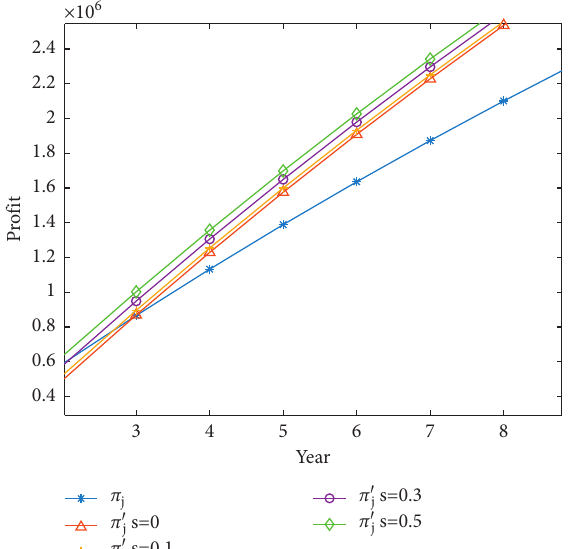
Figure 7: Profits of retailers with q